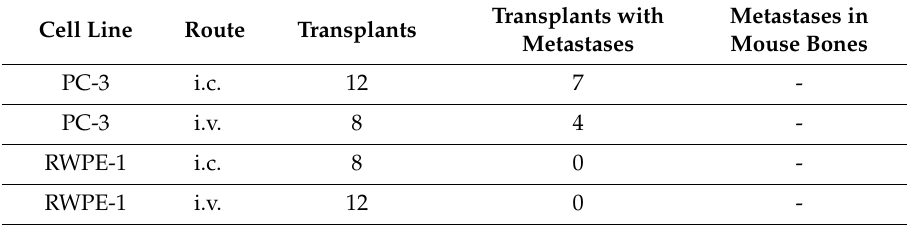
Transplants with Metastases in Metastases Mouse Bones